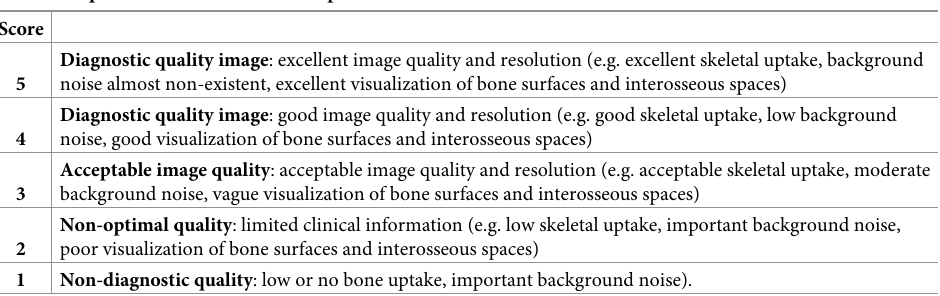
Table 2. 5-point Likert scale with